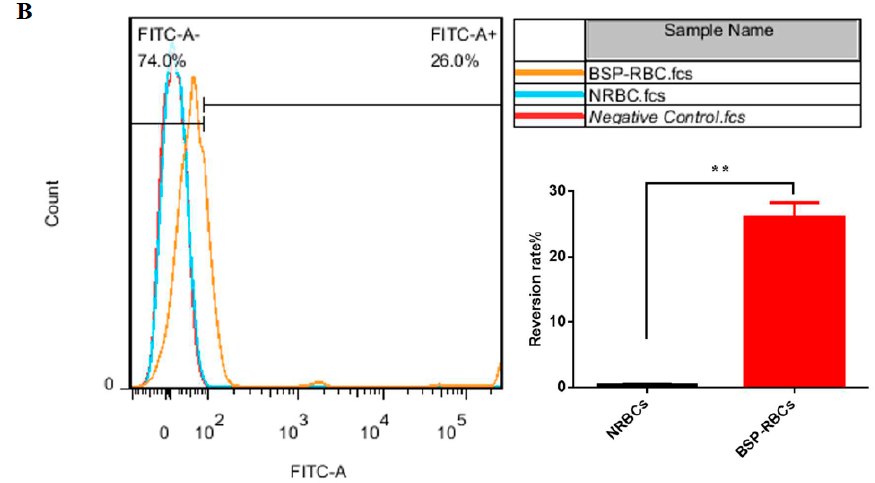
Figure 5. PS surface exposure of NRBCs and BSP-RBCs. ( A ) FSC-SSC scatter plot; ( B ) PS reversion rate. Data are represented as mean ± SD, three samples were used in each group. ** correspond to p < 0.01.